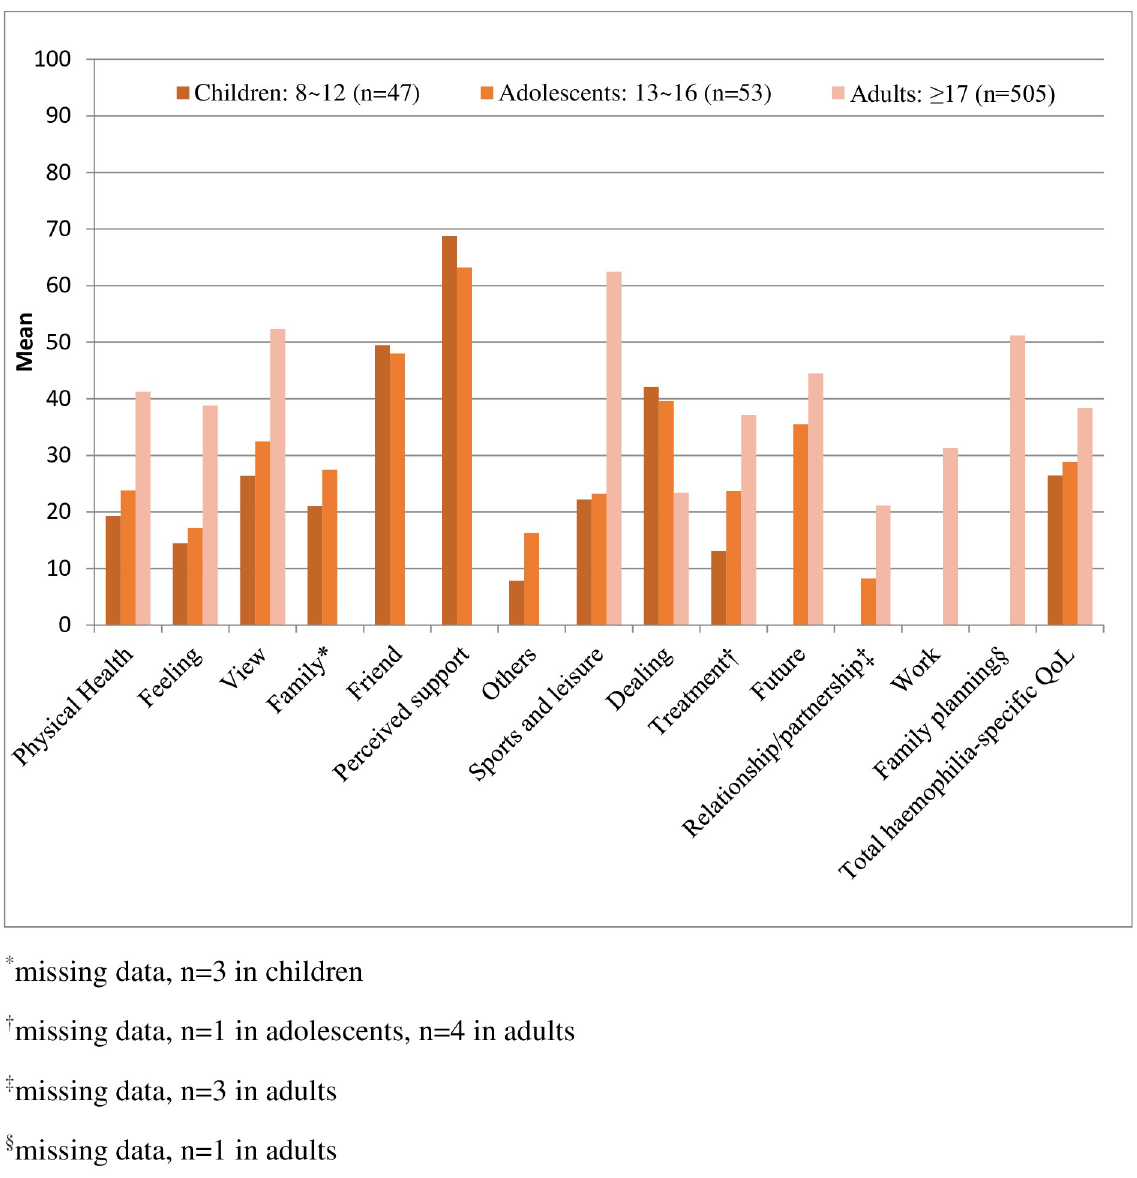
Fig 1. The mean Haemo-QoL questionnaire and Haemo-A-QoL questionnaire scores by age group. 21.15 ± 26.5). In the children and adolescents group, higher scores for the “perceived support” dimension indicated that they perceived insufficient support from others (mean ± SD in the children group, 68.75 ± 25.6; mean ± SD in the adolescent group, 63.21 ± 26.8). Furthermore, interaction with their “friends” was hindered in these groups (mean ± SD in the children group, 49.47 ± 25.1; mean ± SD in the adolescent group, 48.00 ± 19.3). HRQoL was assessed according to the patients’ baseline characteristics. For all measure- ments, HRQoL significantly differed by age group ( p < 0.01). When applying the Bonferroni correction in comparing age groups, patients aged 17 years or older reported more impaired HRQoL than the younger age groups; lower EQ-5D-3L and EQ VAS values were observed